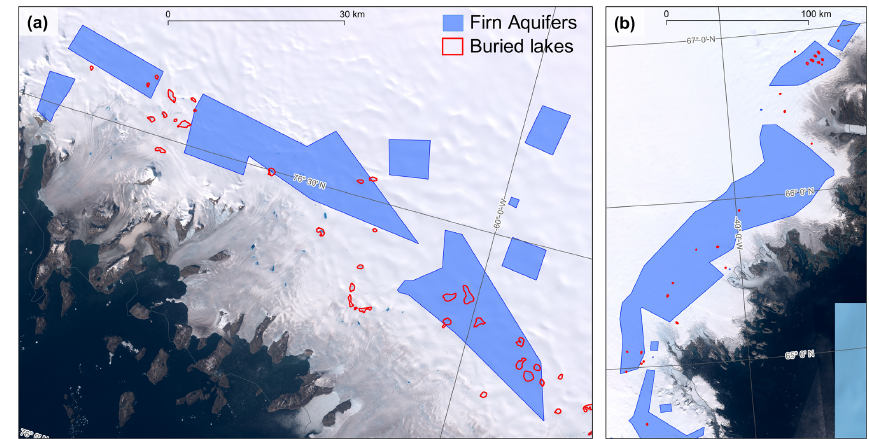
Figure 6. Firn aquifer and detected buried lake locations. (a) The 2015–2017 NW GrIS firn aquifers from Operation Ice Bridge (OIB) (Miège, 2018) and buried lakes following the 2019 melt season. The background image is a S2 image from 1 September 2019. (b) The 2015–2017 SE GrIS firn aquifers from OIB and buried lakes following the 2019 melt season. Background image is a S2 image from 21 July